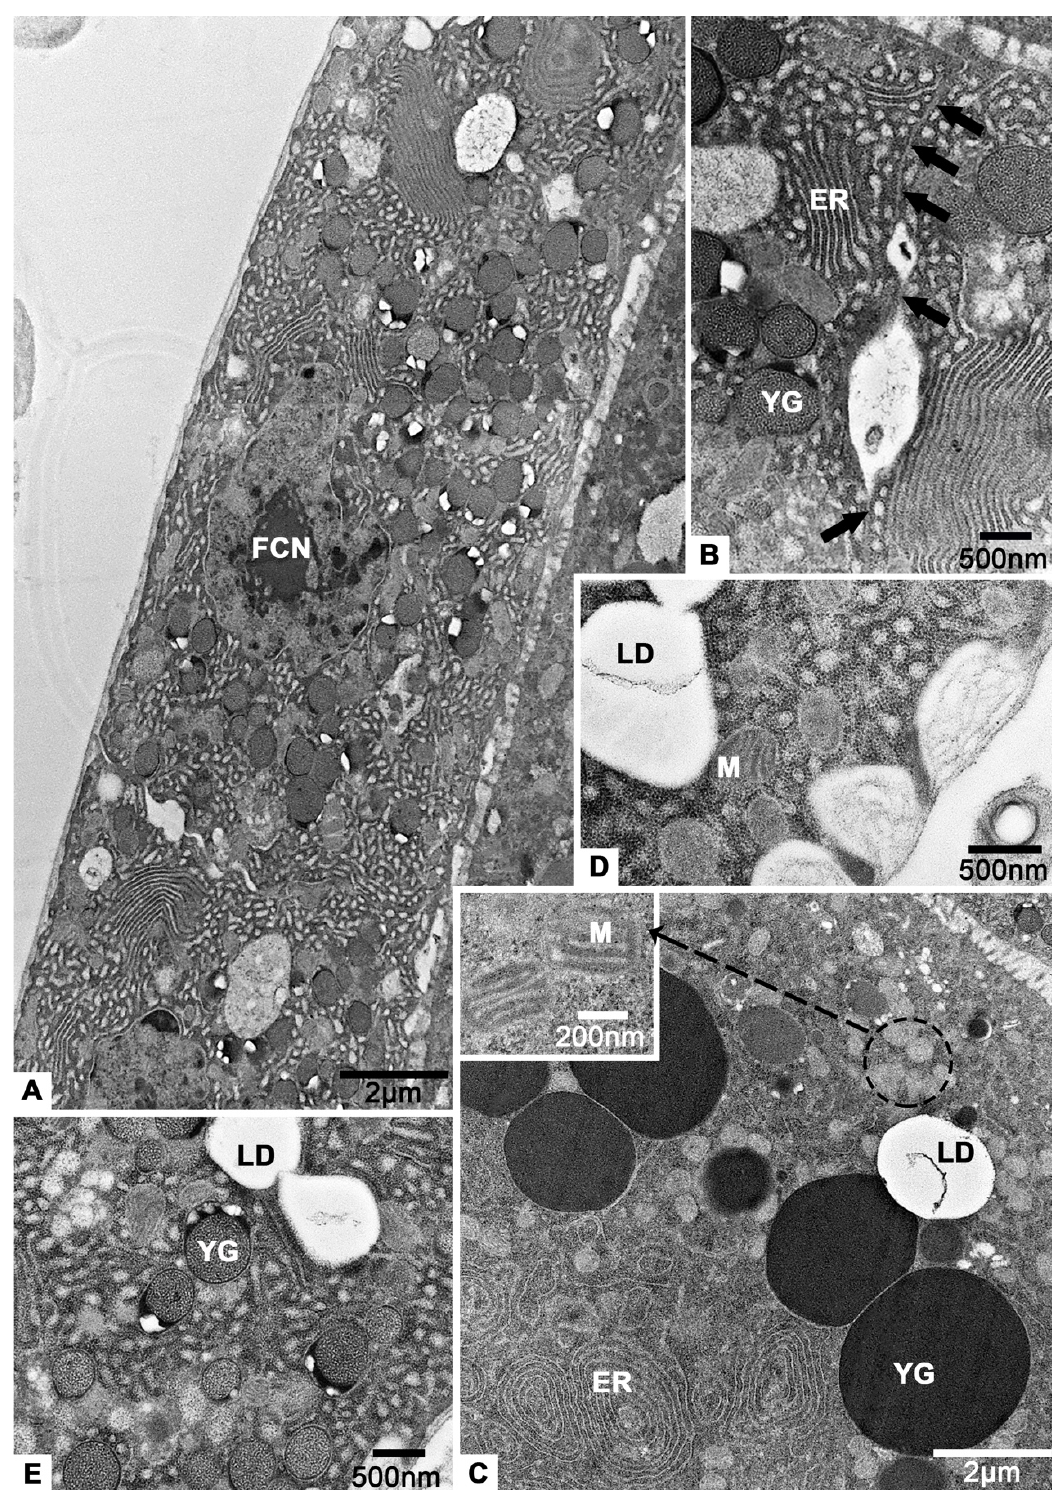
Figure 9. On sixteenth day post-eclosion, the oocyte and follicular cells of T. klimeschi in late vitellogenesis. ( A ) Follicular cells. ( B ) The gap between follicular cells (black arrows). ( C ) Cytoplasmic contents of an oocyte. ( D , E ) Cytoplasmic portions of follicular cells. Nucleus of a follicular cell (FCN); yolk granules (YG); endoplasmic reticulum (ER); lipid droplets (LD); mitochondria (M).